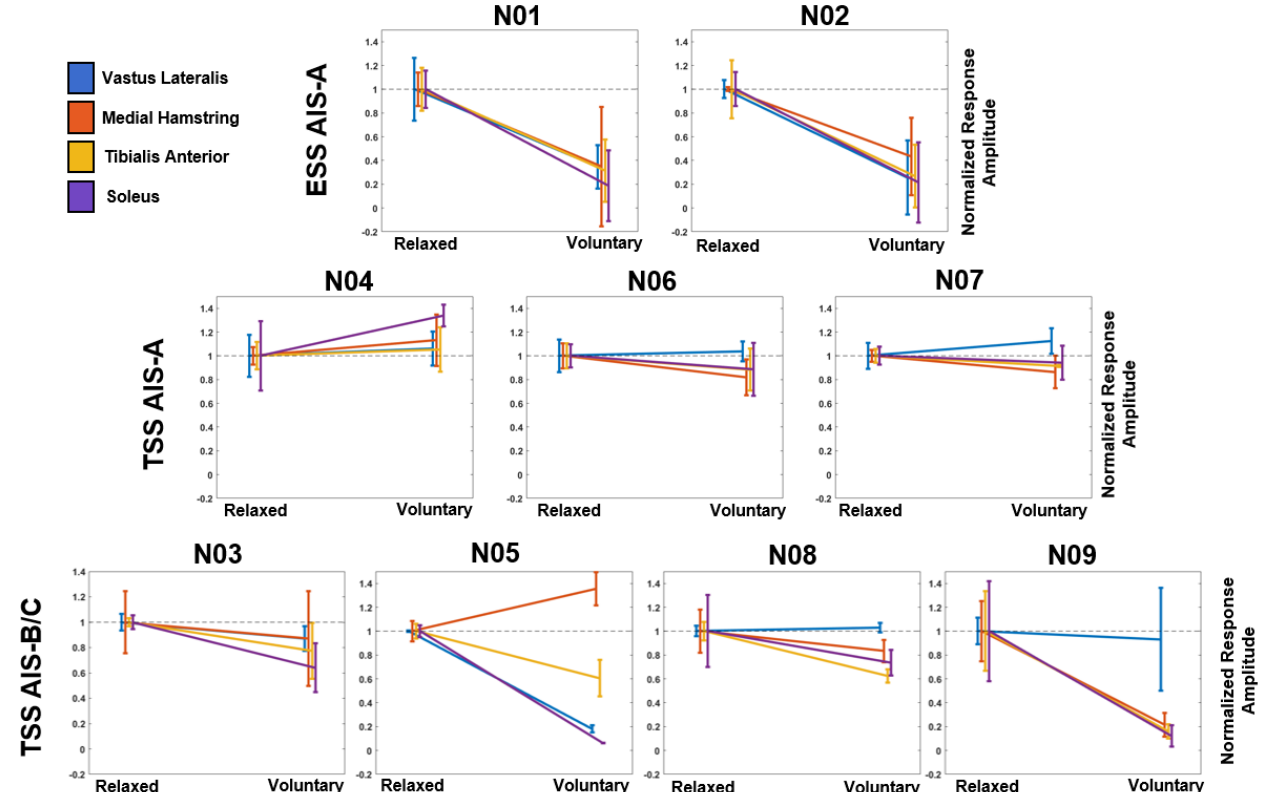
Figure 4. Evoked Response Modulation by ASIA Impairment Score. The first row indicates the two participants with clinically complete SCI tested with ESS. The second row indicates the three participants with clinically complete SCI tested with TSS. The third row indicates the four participants with clinically incomplete SCI tested with TSS. Data on the left of each plot refer to the average evoked response during the relaxed condition, and the data on the right refers to the average evoked response during the voluntary flexion condition. Data are normalized to the maximum EMG response in each muscle in each participant to compare across participants. The black dashed line indicates the average response of each muscle during the relaxed condition. Error bars represent the mean ± standard deviation. AIS—American Spinal Injury Association Impairment Score, VL—vastus lateralis (blue), MH—medial hamstrings (orange), TA—tibialis anterior (yellow), and SOL—soleus (purple).